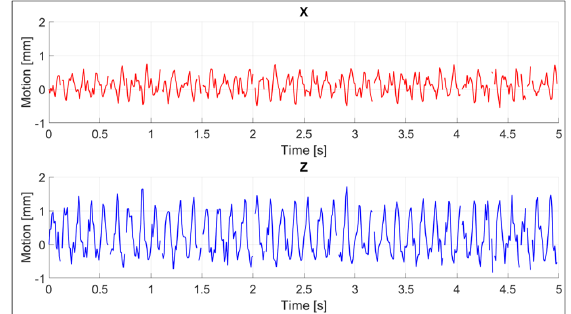
Figure 8. Motion of the rotor blade in X und Z direction